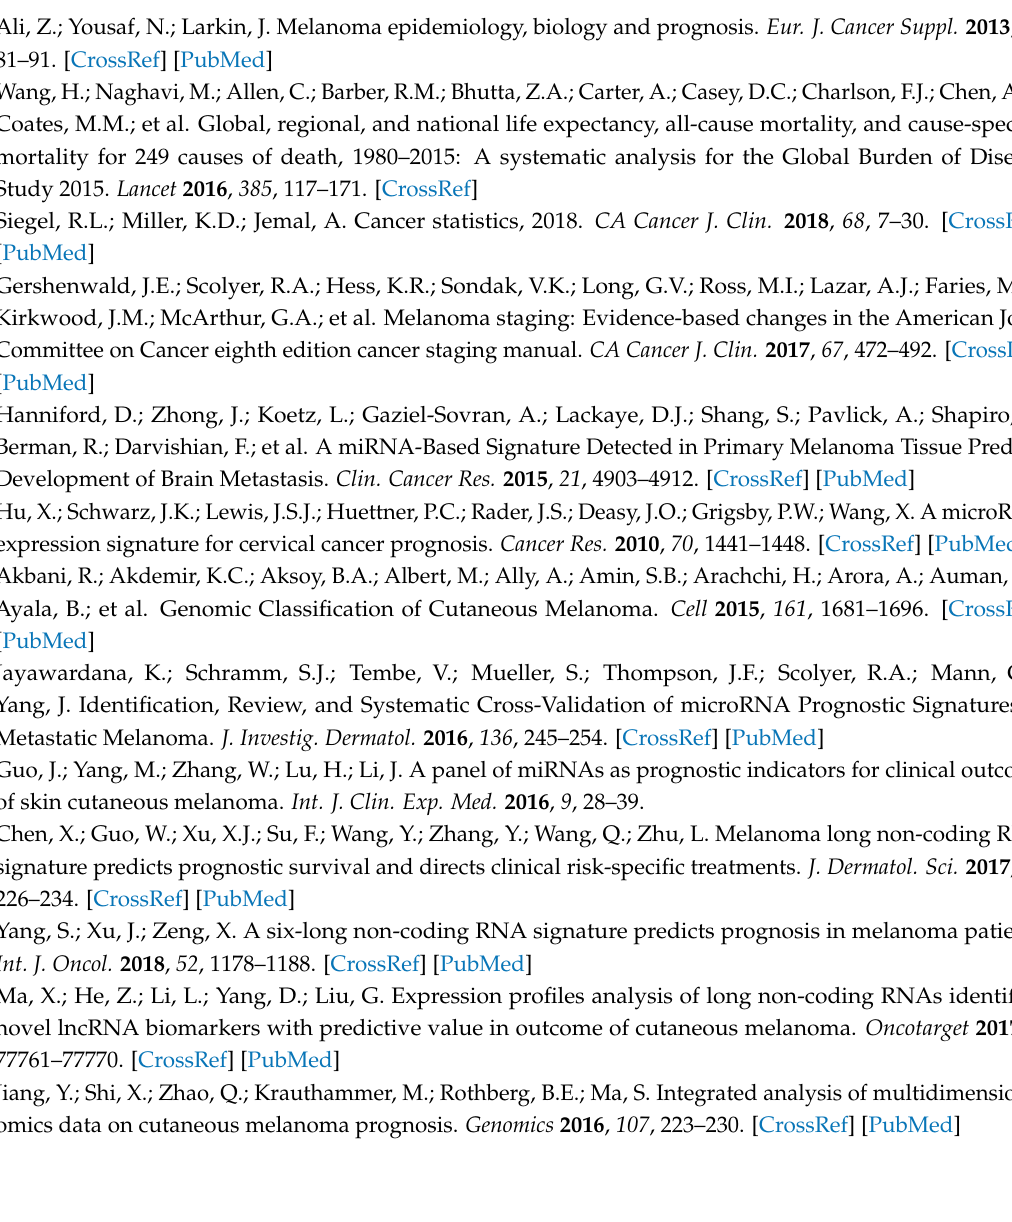
Figure S1: batch effect evaluation; Figure S2: Kaplan-Meier survival analysis of pathological stage; Figure S3: Schoenfeld residuals; Table S1: survival analysis of the four OS associated clinicopathological characteristics based on the OBS; Table S2: univariate analysis of OS associated and the OBS associated miRNAs in TCGA-MCM cohort; Table S3: univariate and multivariate analysis of the five cross-validated miRNAs based on the OBS; Dataset S1: clinical data; Dataset S2: normalized miRNA expression